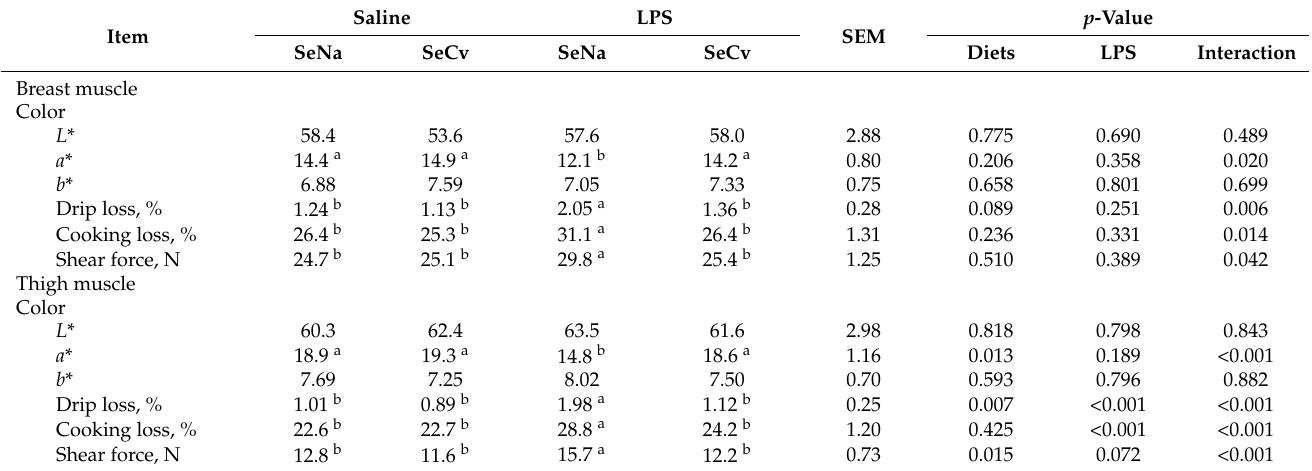
Table 4. Effect of Cardamine violifolia on the meat quality of breast and thigh muscle of broilers challenged and unchallenged intraperitoneally with